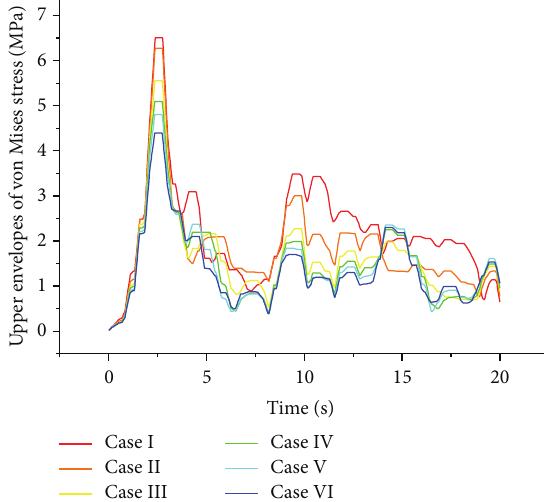
Figure 8: The envelopes of displacement time history at Point 1.